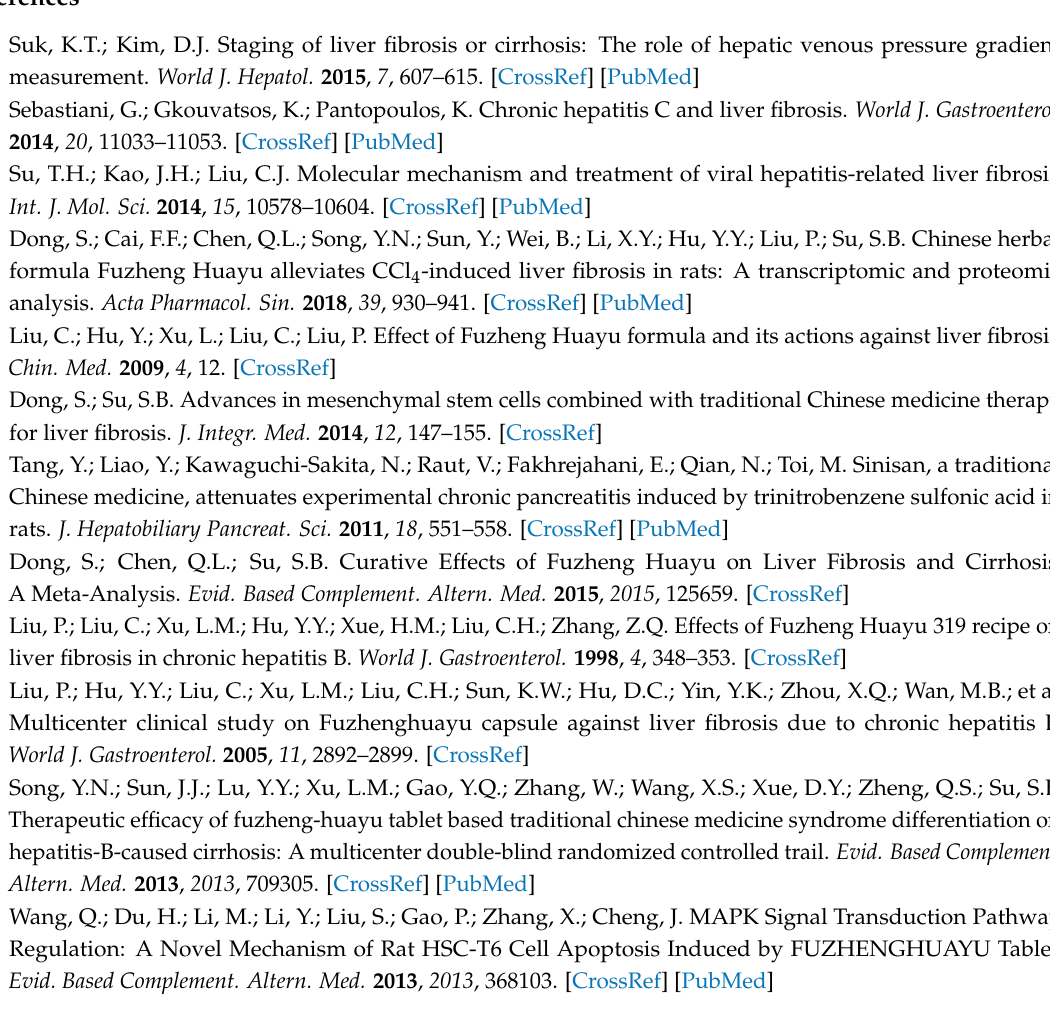
Supplementary Materials: The following are available online, Figure S1: The full-length gels and blots of western blot, Figure S2: Chemical structures of kaempferol, hederagenin, beta-sitosterol, luteolin and tanshinone IIa, Figure S3: HPLC-MS MRM chromatogram of FZHY extracts and FZHY-medicated serum samples, Table S1: All DEGs of FZHY rats, Table S2: All targets of FZHY, Table S3: All direct related genes of DEGs, Table S4: All potential targets of FZHY in anti-fibrotic effects, Table S5: All pathways of potential targets, Table S6: Raw microarray data, Table S7: Herb-compound-target-signaling pathway of